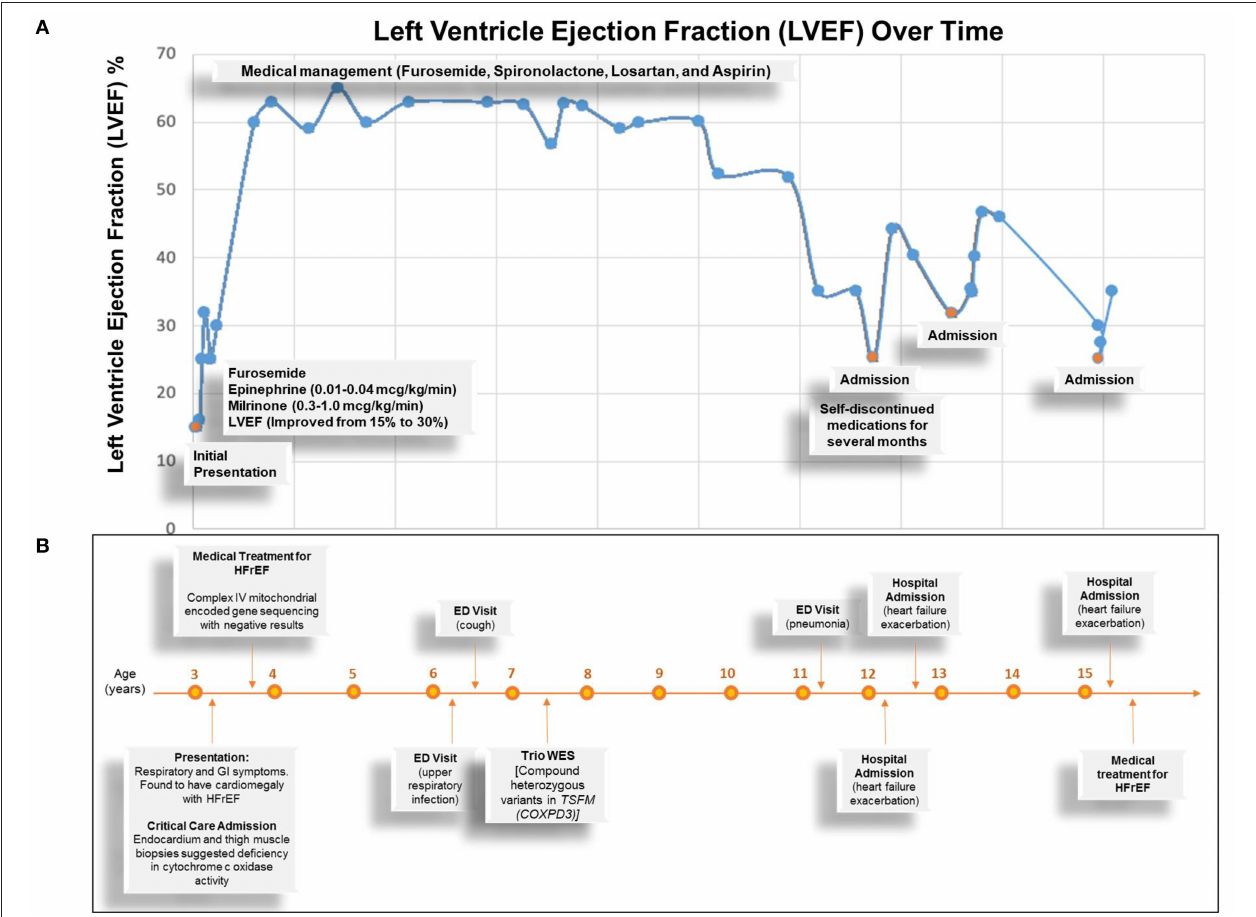
FIGURE 4 | Summary of Clinical Time Course of the Proband. (A) Graph depicts left ventricle ejection fraction percentage overtime. Blue dots represent the time of measurements. Orange dots represent the times of admission and related events (texts). (B) Summary of clinical time course depicts important clinical events over time. HFrEF, heart failure with reduced ejection fraction; ED, emergency department; COXPD3, combined oxidative phosphorylation deficiency